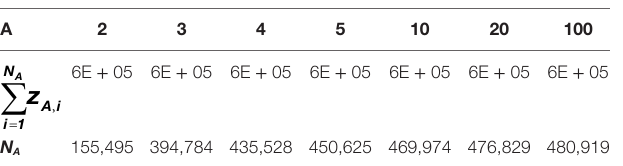
TaBle 2 | Summary of the simulated Zipf distributions.